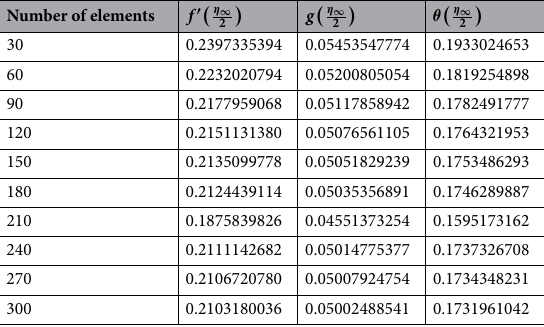
Table 2. Mesh-free simulations of velocities and temperature via 300 elements 34 .